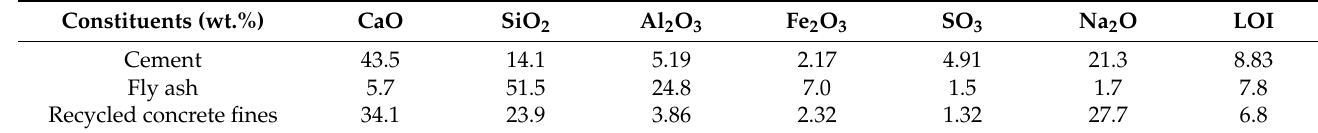
Figure 1. ( a ) XRD pattern and ( b ) SEM image of recycled concrete fines. Table 2. Chemical components of raw